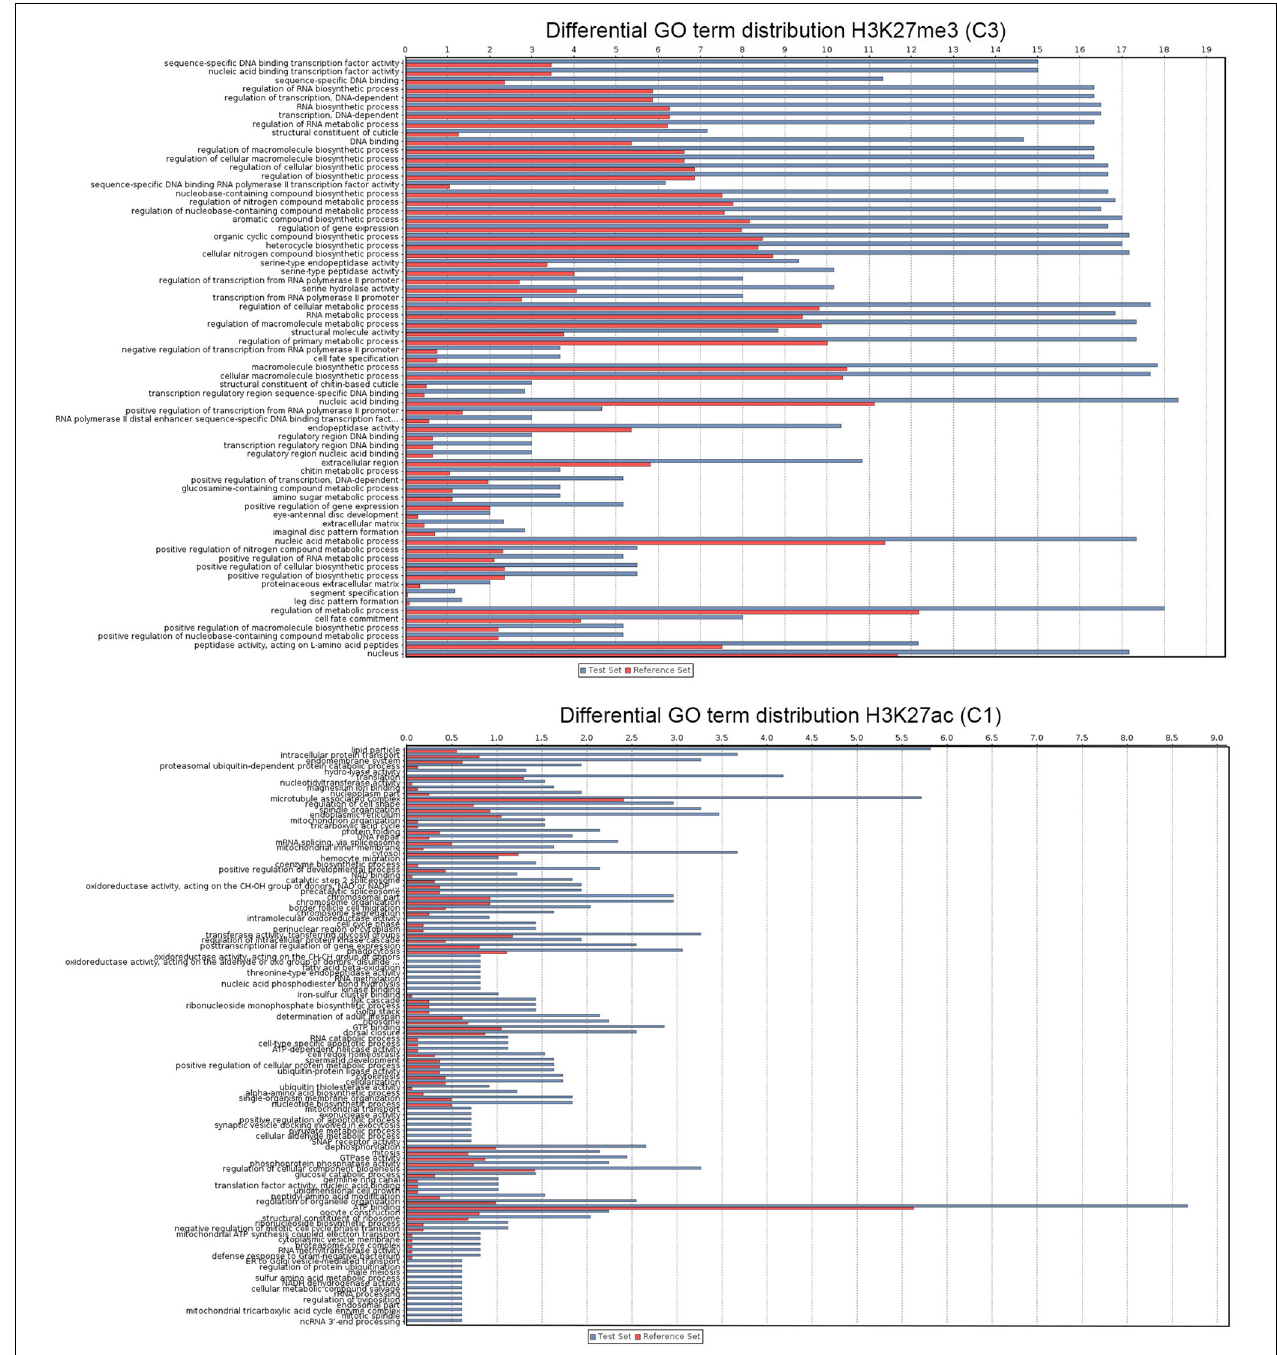
FIGURE 3 | Functional analysis of A. gambiae genes. The graphs show GO terms significantly associated with genes that show significant enrichment or depletion of H3K27ac and H3K27me3 at high levels (see Figure 2 ). Bars corresponds to number of